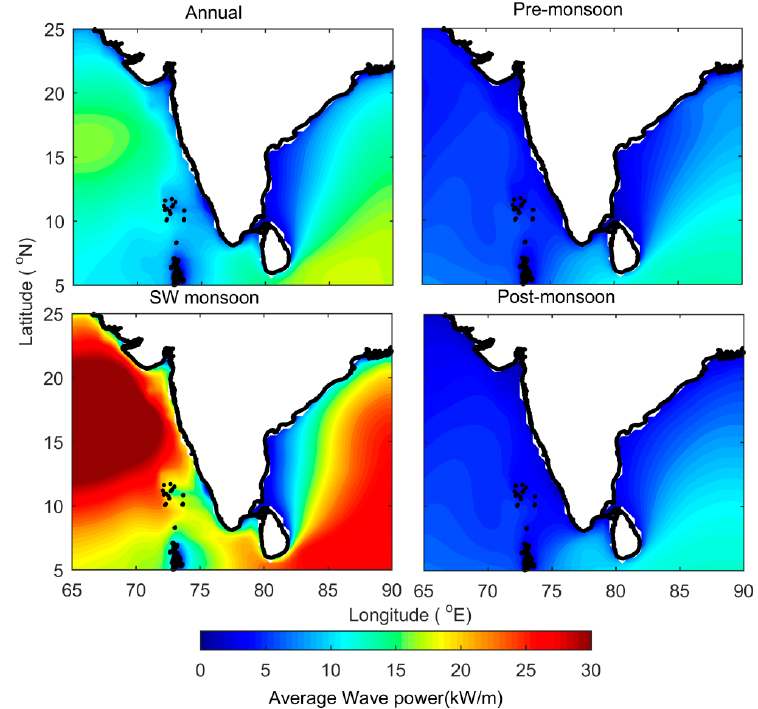
Figure 3. Annual and seasonal mean wave power averaged over 40 years (1979 to 2018) for the study area in the North Indian Ocean during pre-monsoon (February–May), southwest monsoon (June–September), and post-monsoon